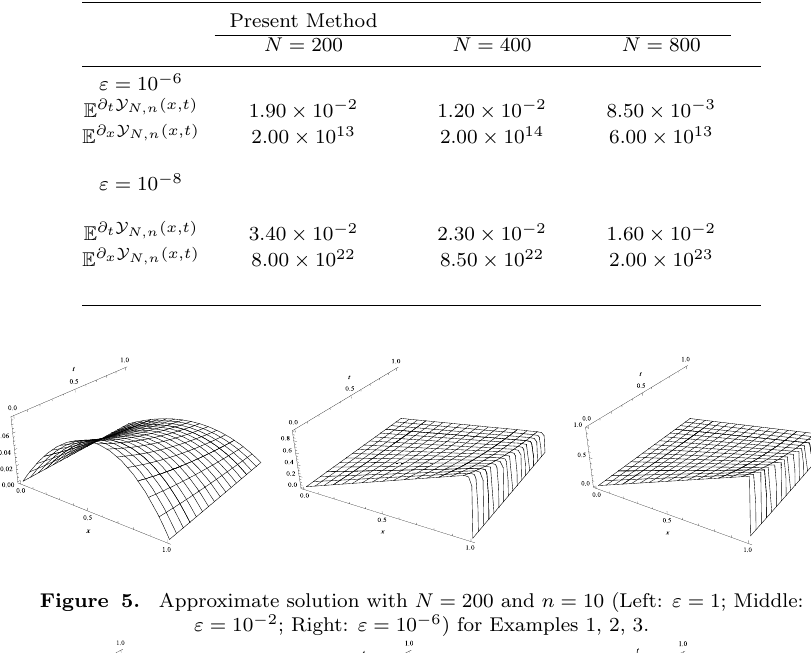
Table 3. Max absolute errors for derivative of the approximate solutions in Example 3.